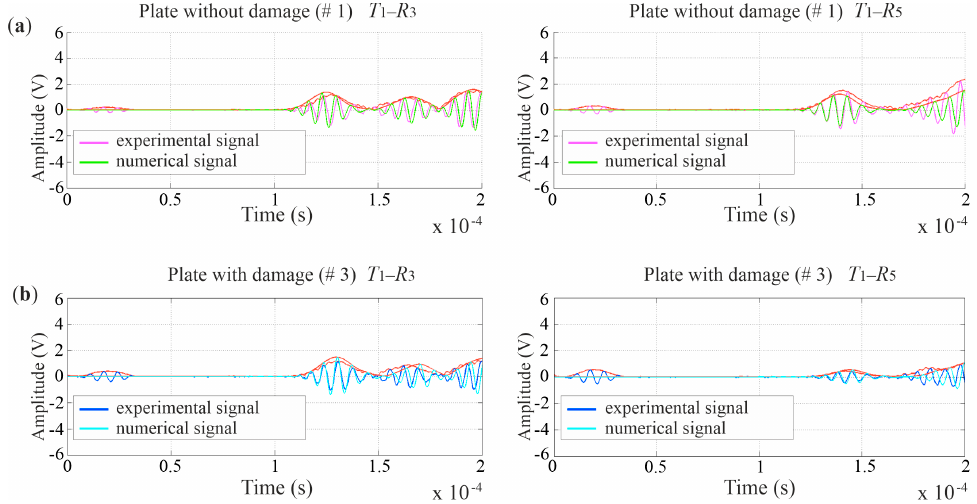
Figure 7. Comparison of selected Lamb wave signals for experimental and numerical tests in a plate without damage ( a ) and with damage ( b ).